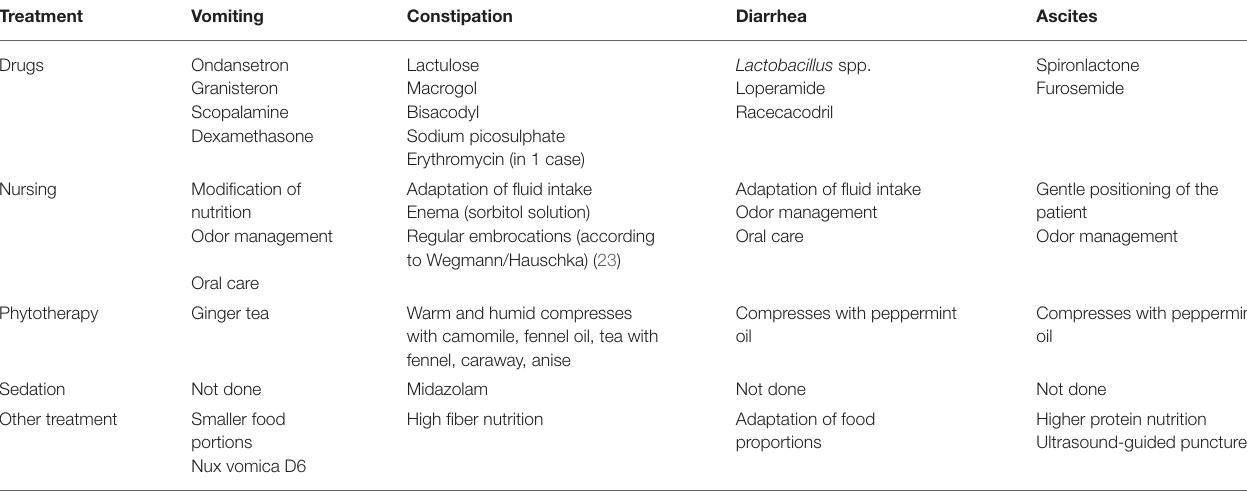
TABLE 1 | Treatment summary.